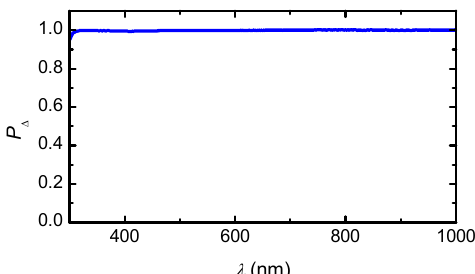
Figure 5. Polarization index from Equation (2) of the experimental Mueller matrix in Figure 4.